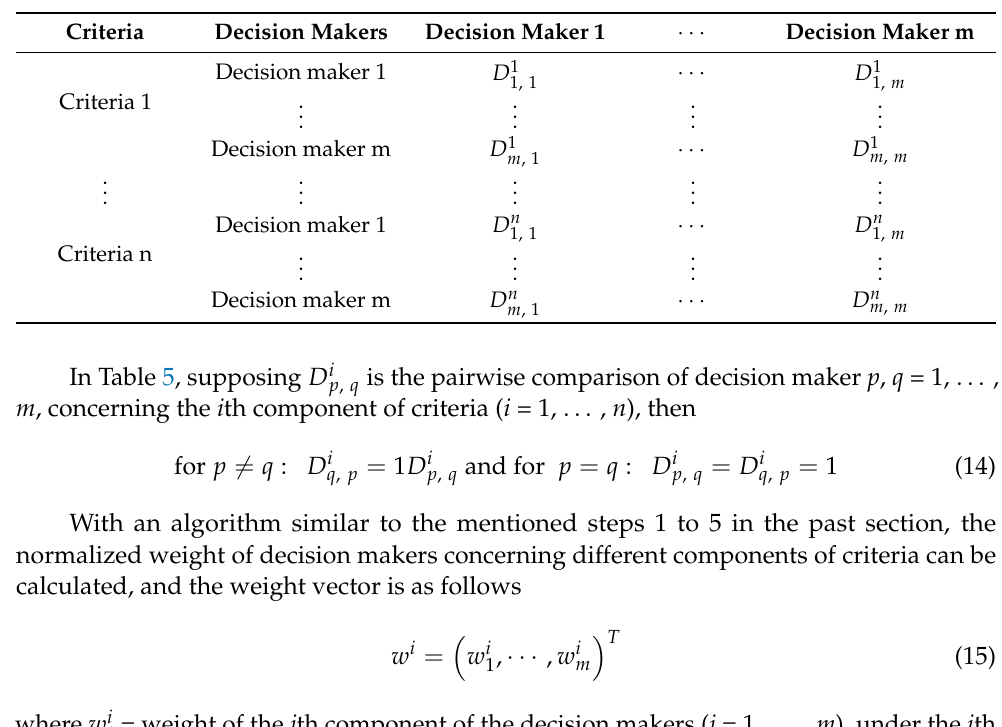
Table 5. Pairwise comparison of decision maker components concerning components of criteria.